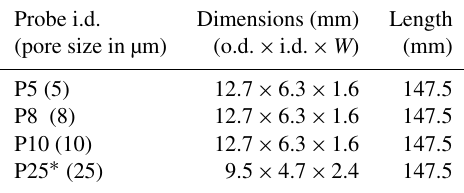
Table 1. sPTFE probe pore size and dimensions including outer diameter (o.d.), inner diameter (i.d.), and wall thickness ( W ). Probe